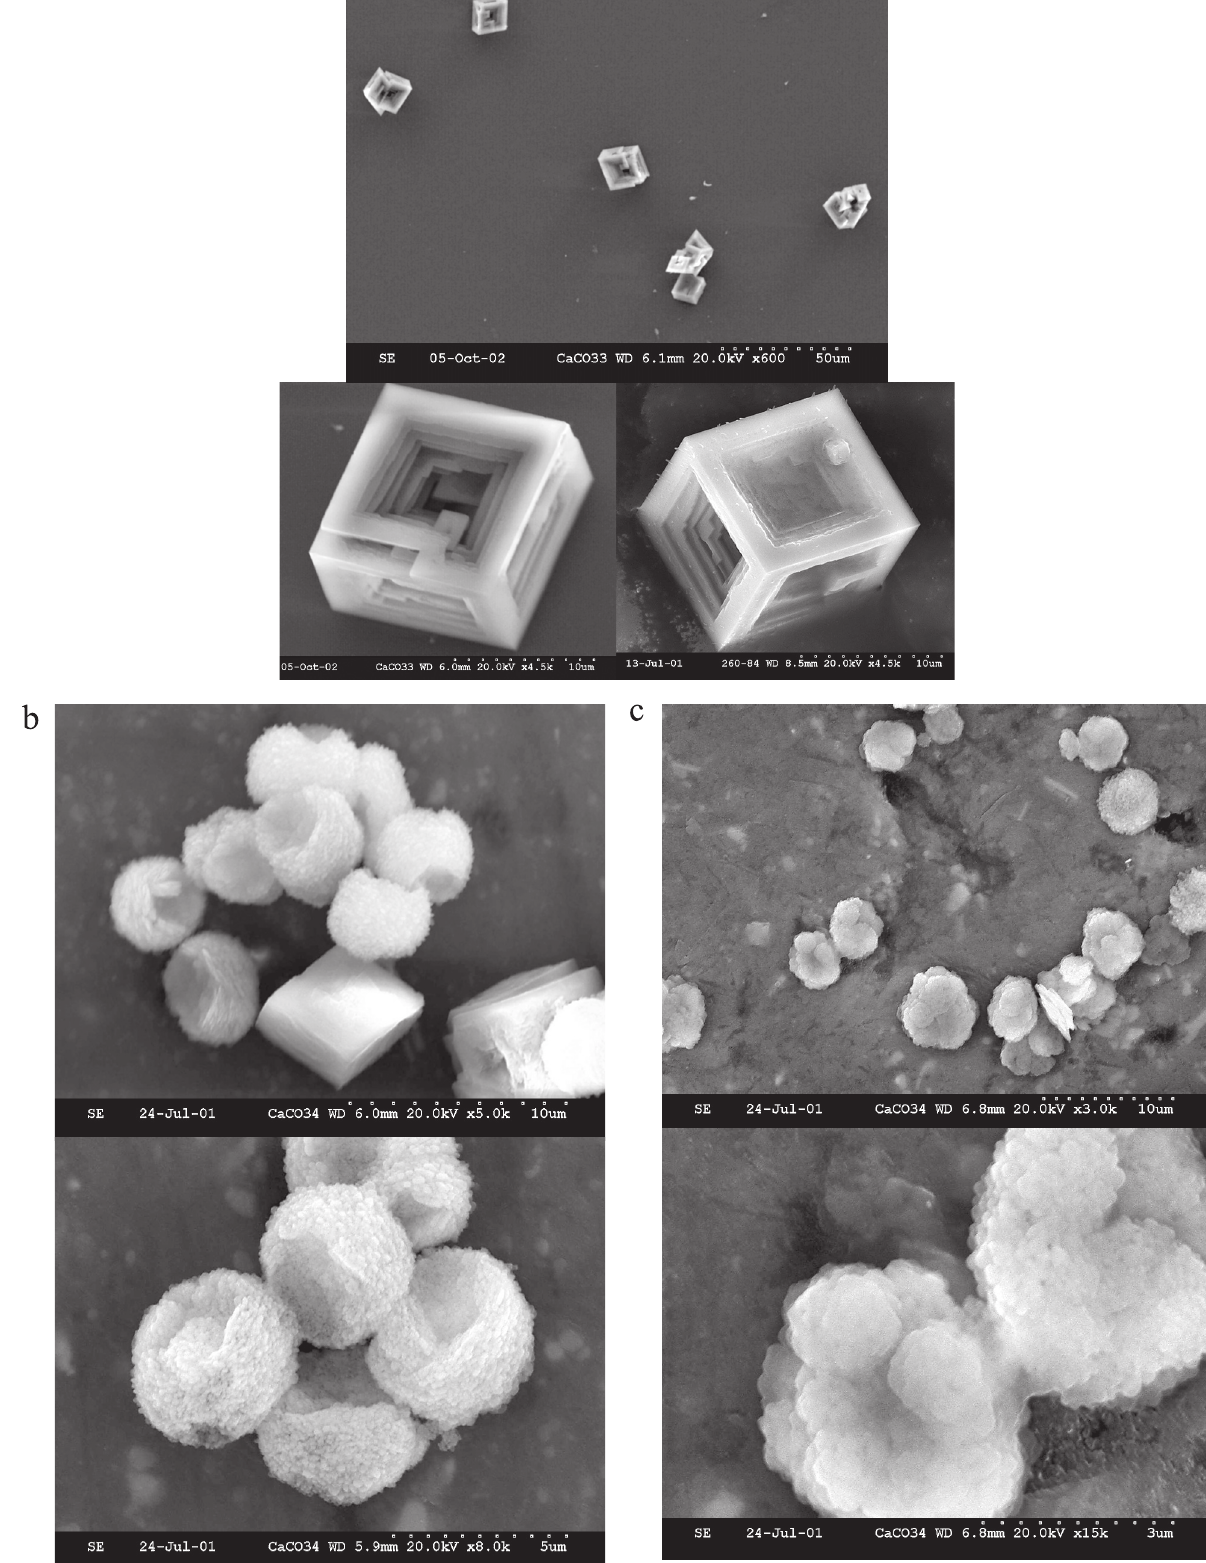
Fig. 2 SEM micrographs of CaCO 3 particles prepared from octylamine/water bilayer systems. ( a ) R = 16.0, hopper crystals of cal- cite, ( b ) R = 10.8, sphere-like and rhombohedral CaCO 3 particles, ( c ) R = 7.2, tabular CaCO 3 particle aggregate. R is the molar ratio of water to